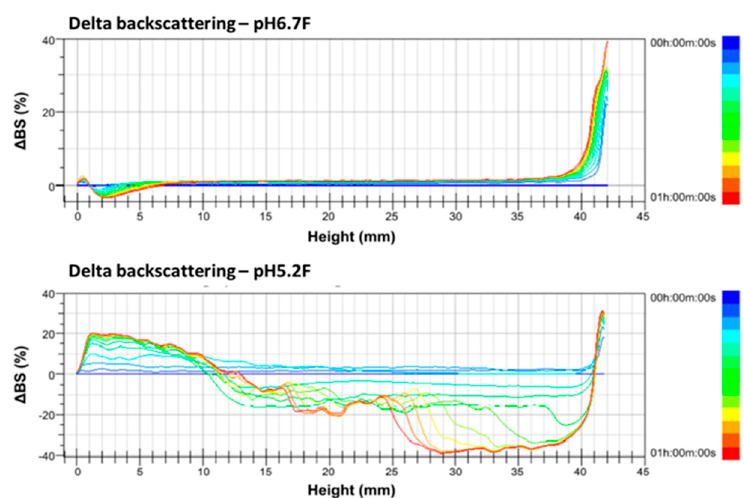
Figure 3. Delta backscattering profiles of pH 6.7 and 5.2 of skimmed Alpine goat milk. The data are reported as a function of time (0–60 min) and sample height (0–42 mm).